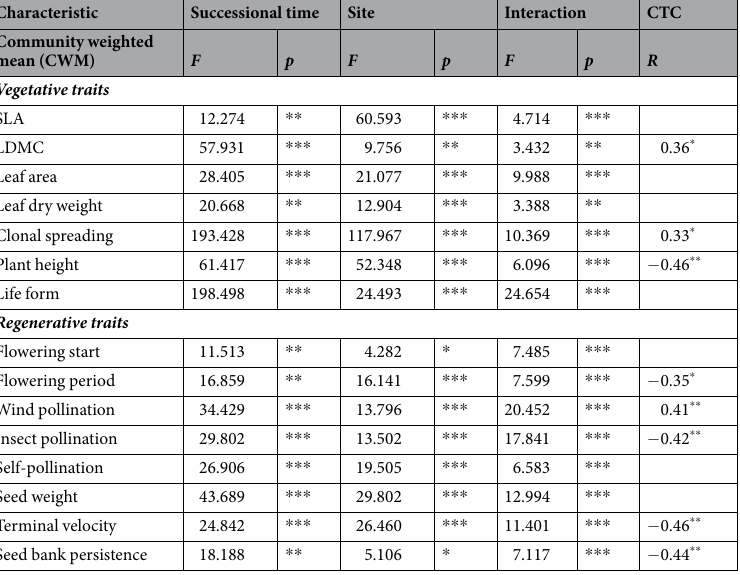
Table 1. Effects of site and successional time on community-weighted means (CWMs) of vegetative and regenerative traits in recovering sand grasslands. Two-way repeated measure GLM with ‘site’ as fixed